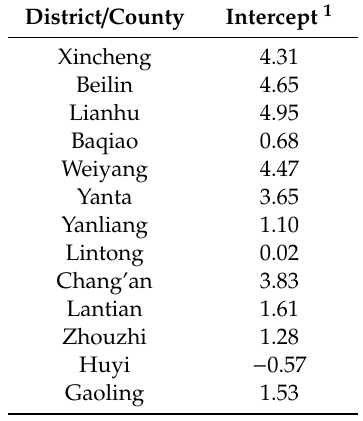
Table 5. Random e ff ects for the 13 districts / counties in the Xi’an study